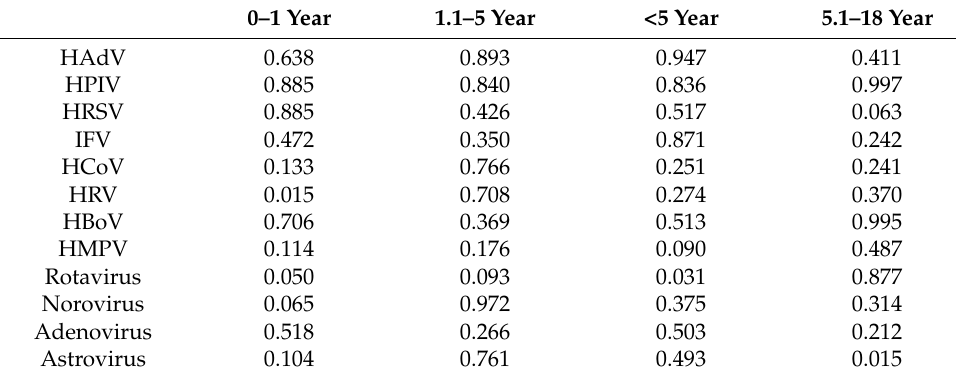
Table 3. Causality of Immune Thrombocytopenia (ITP) incidence after 2 months with